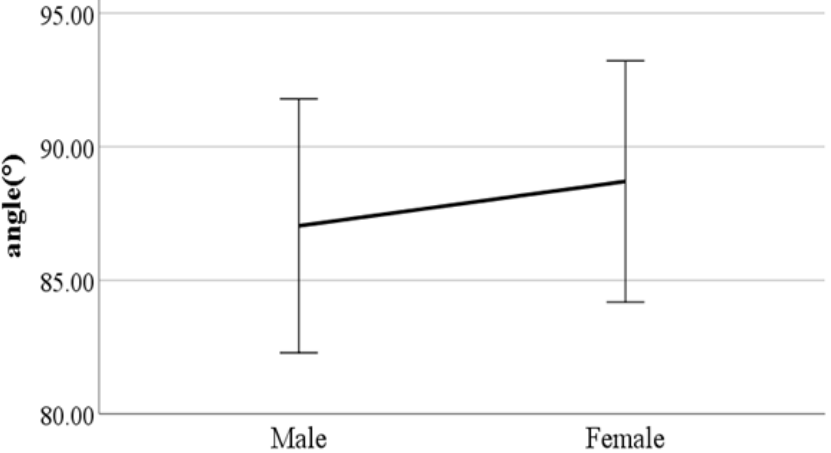
Figure 16. Gender difference in lateral trunk flexion at the double support phase (right foot forward) (F value: 0.01, DF: 289, p -value: 0.04).